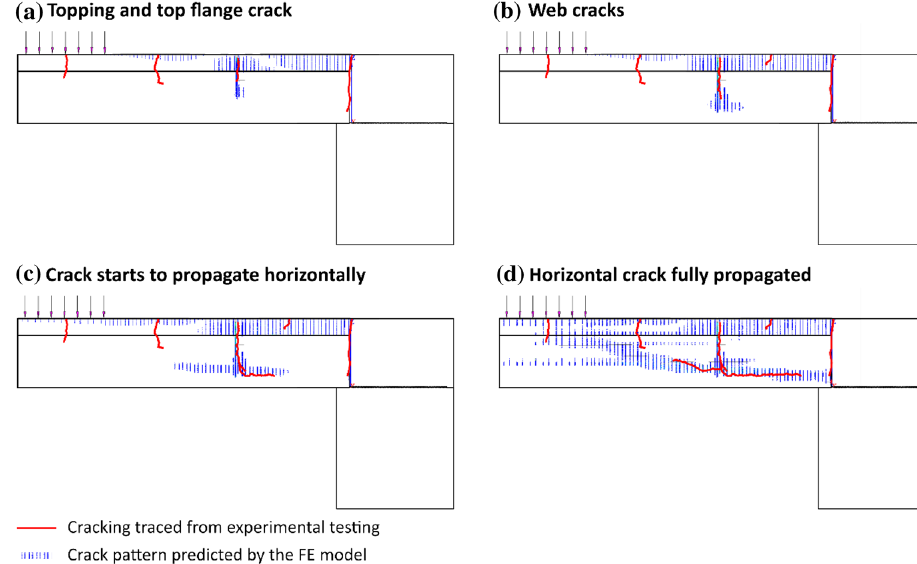
Fig. 10 Comparison of the crack pattern predicted by the FE model and the cracks traced from the experimental